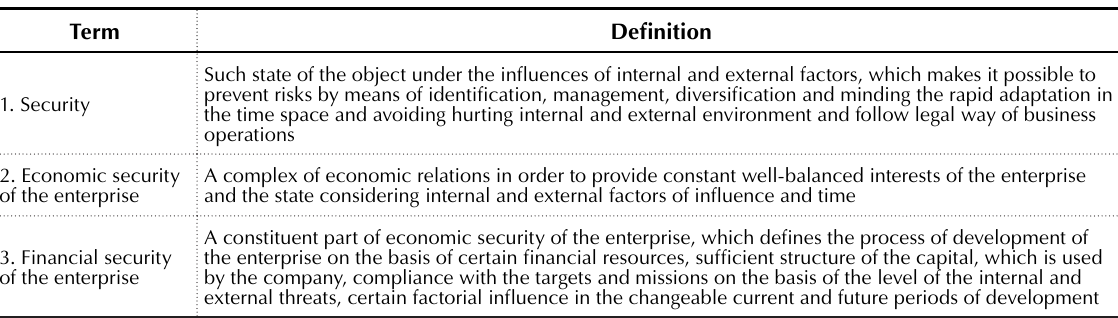
Source: Developed by the authors.